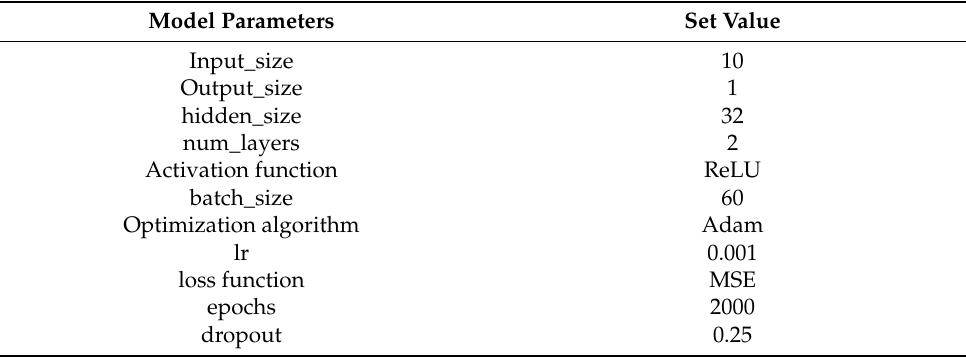
Table 4. Prediction Model-Related Parameter